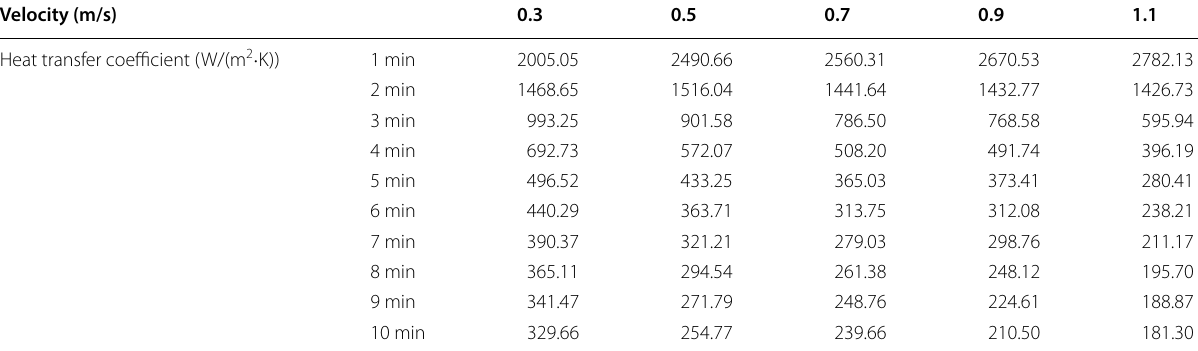
Table 3 Heat transfer coefficient of the respective velocities after the experiment Velocity (m/s)